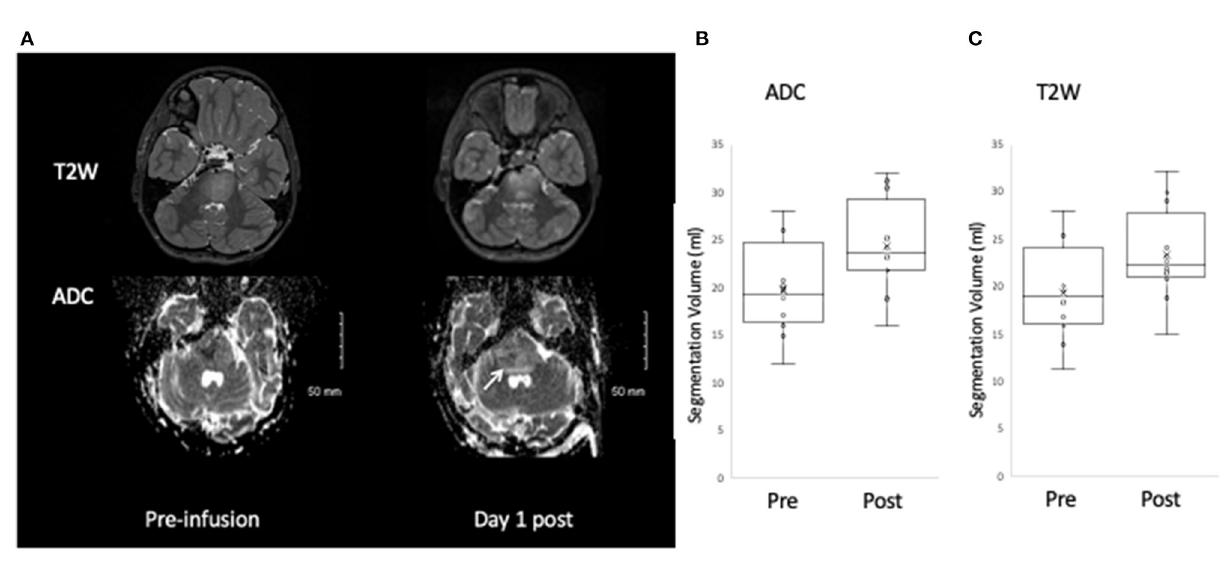
FIGURE2 Change in T2W and ADC post infusate. An increase in the area of T2W and ADC hyperintensity is observed post infusion (A) , which on quantitative analysis corresponds to a significant increase in segmentation volume defined by ADC hyperintensity (B) and T2W hyperintensity (C)